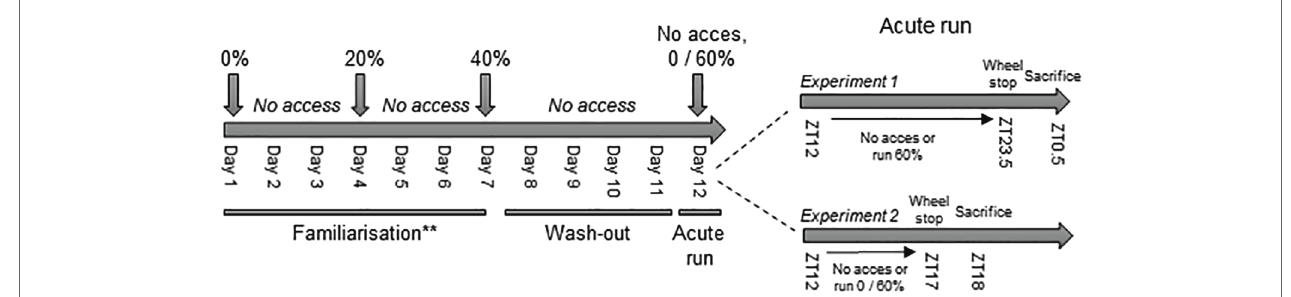
FIGURE 1 | Experimental set-up. ** In experiment 1, only the VResRun group was familiarized to the wheel. The Sed remained sedentary during the whole experiment. In experiment 2, all groups were familiarized to the wheel, including the